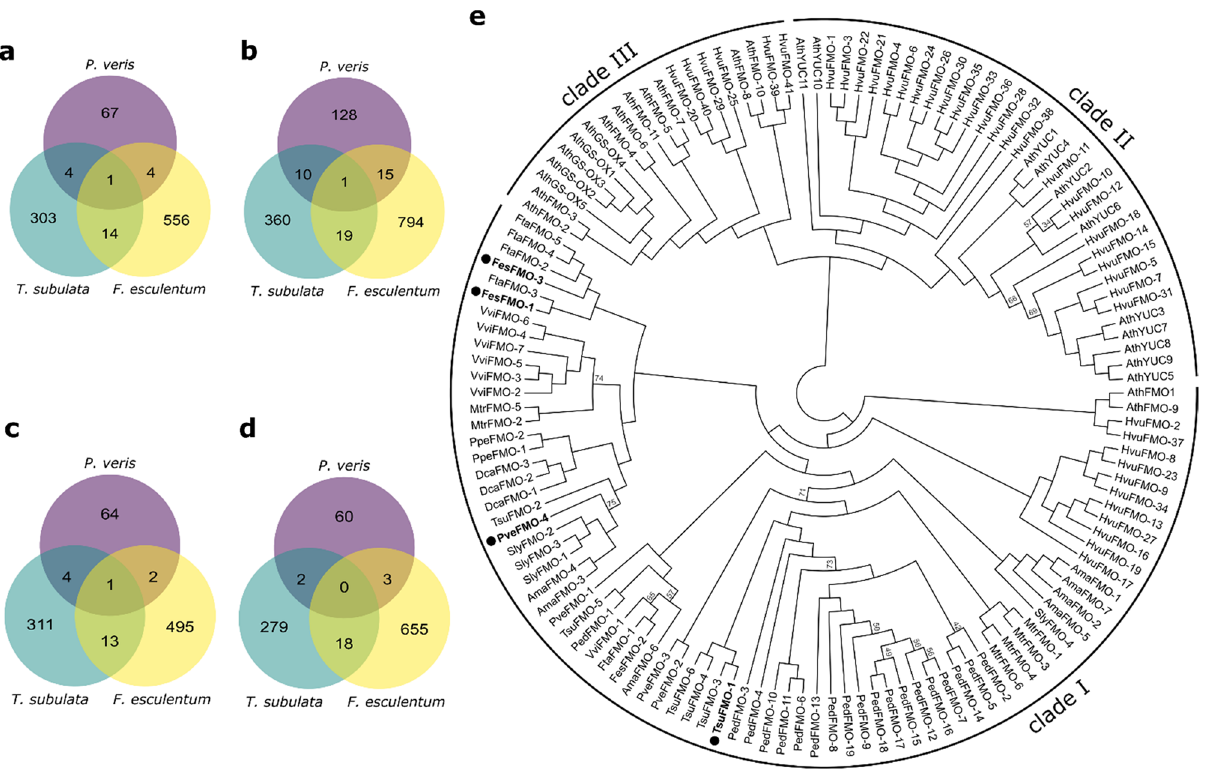
Figure 6. Orthogroups containing genes differentially expressed in P. veris , F. esculentum and T. subulata . ( a )–( d ) Venn diagrams showing the number of orthogroups containing differentially expressed genes between L- and S-morphs of P. veris (purple), F. esculentum (yellow) and T. subulata (green). ( a ) Orthogroups containing genes up-regulated in female organs. One orthogroup (OG0000318) contains genes up-regulated in female organs in the three species (pveT_jg29738, tr_14668, Tsub_00016967-RA), annotated as HSL3 receptor kinases. ( b ) Orthogroups containing genes down-regulated in female organs. One orthogroup (OG0000198) contains genes down-regulated in female organs in the three species (pveT_jg28601, tr_16287, Tsub_00008119-RA, and Tsub_00000118-RA), annotated as PIP aquaporins. ( c ) Orthogroups containing genes up-regulated in male organs. One orthogroup (OG0000315) contains genes up-regulated in male organs in the three species (pveT_jg17457, tr_6752, Tsub_00026904-RA, and Tsub_00006450-RA). ( d ) Orthogroups containing genes down-regulated in male organs. No orthogroup contains genes down-regulated in male organs in the three species. ( e ) Cladogram of the OG0000315 orthogroup genes, which contains genes annotated as FMOs, plus A. thaliana and H. vulgare FMOs. Bootstrap values < 75 are shown. The P. veris , F. esculentum and T. subulata DEGs are boldfaced. To ease visualization, genes from the different species are indicated with the prefixes as in Fig. 5f, plus H. vulgare , and D. carota , indicated as Hvu and Dca, respectively (details on the nomenclature in Suppl. Table S19. Genes that were differentially expressed between L- and S-morphs are boldfaced and marked by black